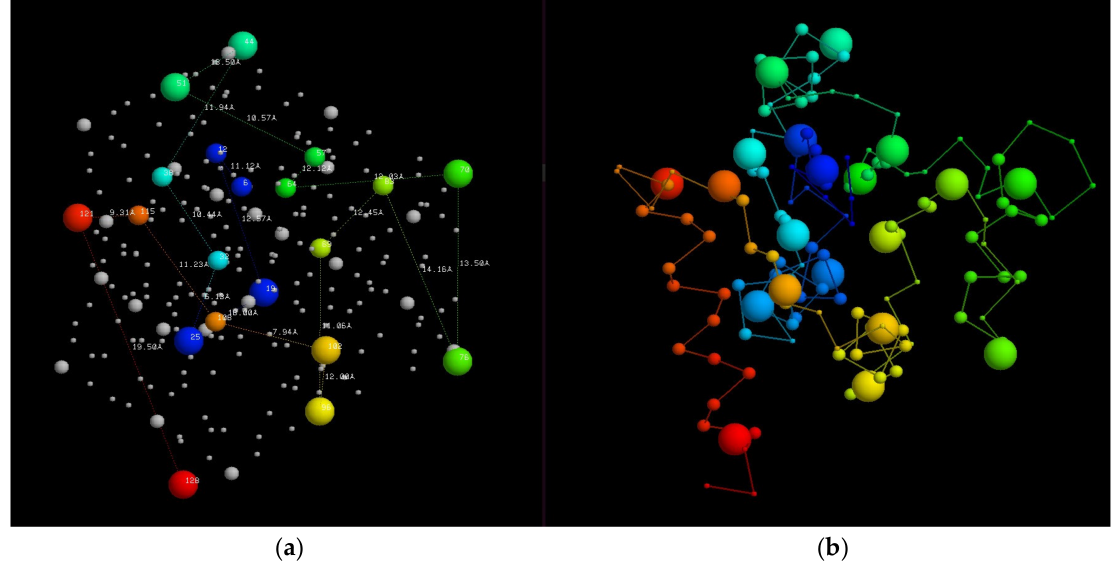
Figure 9. An augmented Bernal lattice: ( a ) a fragment of a Bernal lattice (large dots) is augmented with an additional pair of points along each edge (small dots). Vertices are selected (coloured) to represent the path of a protein chain ( b ) with helices on lattice edges and strands along lines connecting satellite points. Cα atom positions are marked by small spheres which are linked by a fine line. Points are coloured blue to red following the chain from its amino to carboxy terminus.